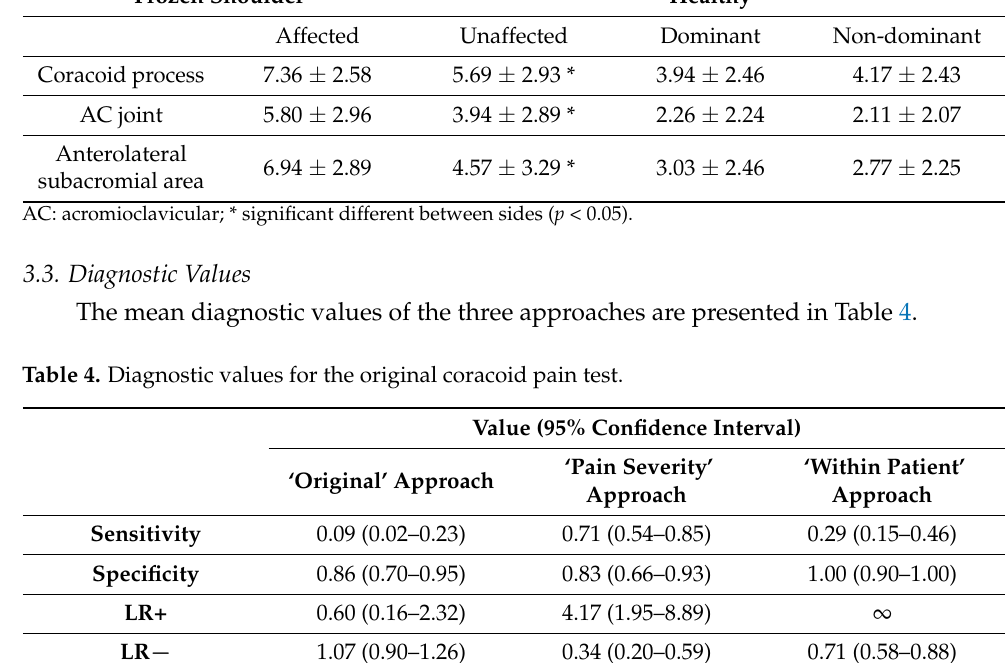
Table 3. Pain (VAS) scores in mean ± SD in the three different areas for both groups. Frozen Shoulder Healthy Affected Unaffected Dominant Non-dominant Coracoid process Anterolateral subacromial area